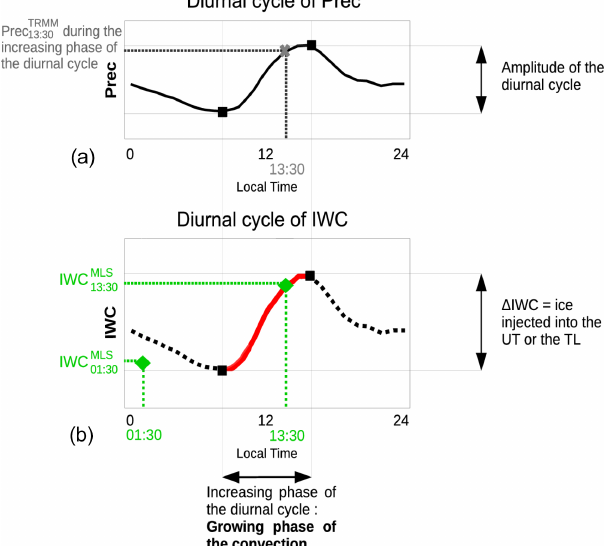
Figure 1. Illustration of the model developed in Dion et al. (2019) to estimate the amount of ice ( (cid:49) IWC) injected into the UT or the TL. Diurnal cycle of a proxy for deep convection (Prec) (a) and diurnal cycle of ice water content (IWC) estimated from diurnal cycle of the proxy for deep convection (b) . The red line is the increasing phase of the diurnal cycle and the dashed black line the decreasing phase of the diurnal cycle. The green diamonds are the two IWC MLS mea- surements from MLS. The grey thick cross represents the measure- ment of Prec during the growing phase of the convection (Prec x ), used in the model. The maximum and minimum of the diurnal cy- cles are represented by black squares. The amplitude of the diurnal cycle is defined by the differences between the maximum and the minimum of the cycle.